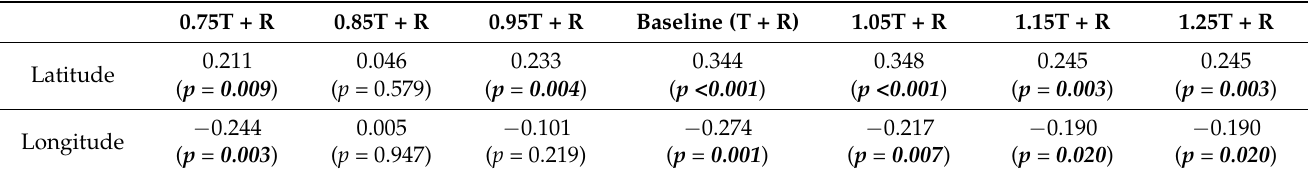
Table A2. Correlations between latitude/longitude and bog blueberry fruit-set in the 151 regions in Northeast China with changes in precipitation from − 25% to 25% (Pearson’s product-moment correlation test) when air temperature was kept the same as the baseline scenario. Bold and italic numbers indicate statistically significant correlations ( α = 0.05). T + 0.75R T +